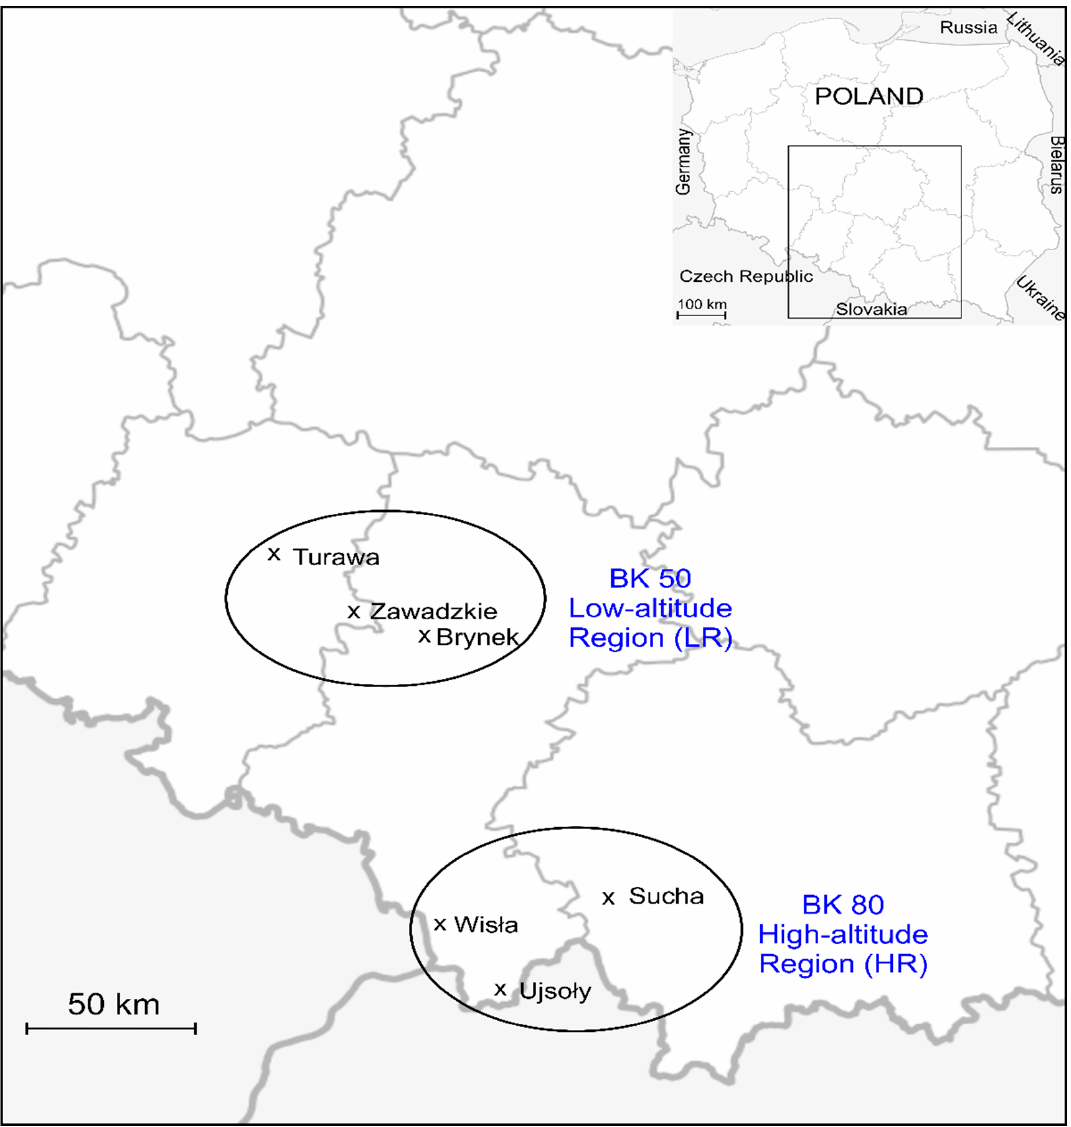
Figure 1. Map of Poland with the locations of the beech populations and regions of origin of the seeds used in the experiment.